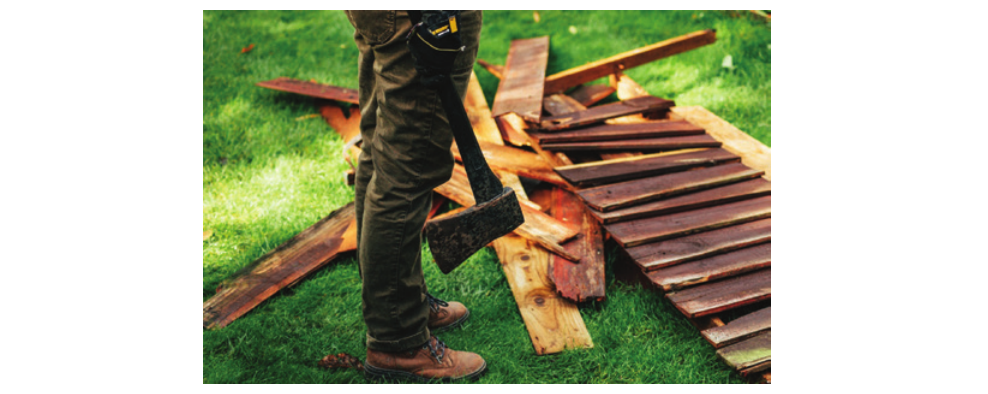
figure 6: Behind the scenes of Lost Property (photograph: clement